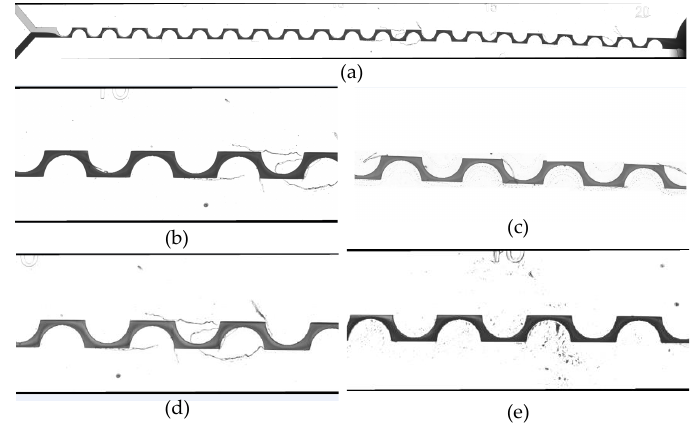
Figure 2. Examples of the processed images: ( a ) full stitched image; ( b – e ) fractions of processed images showing different noise levels and shades for the outline.